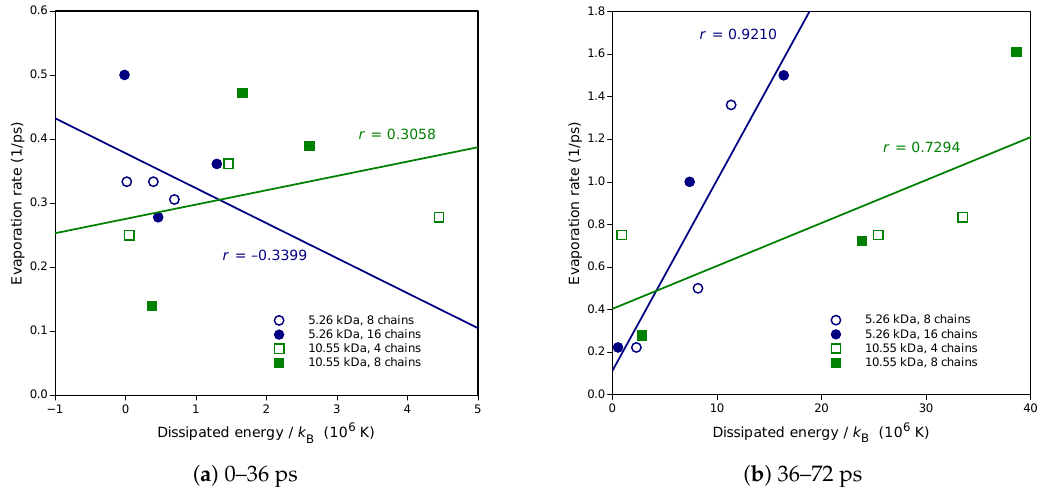
Figure 25. The solvent evaporation rate vs the dissipated energy divided by k B for ( a ) 0–36 ps and ( b ) 36–72 ps of production time. Simulation data (symbols) are shown along with a linear least-square regression (line). Pearson’s correlation coefficients, r , are also displayed alongside the regression lines. Results for 8 or 16 5.26-kDa PEG chains (open or filled blue circles), and for 4 or 8 10.55-kDa PEG chains (open or filled green squares) are shown. Plotted by Gnumeric [57] and edited with Inkscape